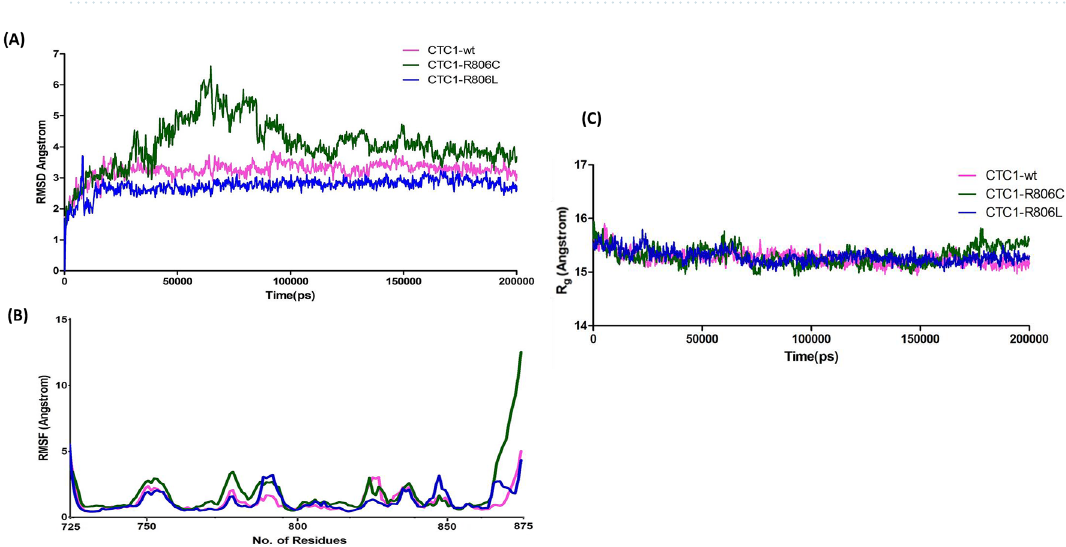
Figure 9. Conformational changes in CTC1 protein and its mutants. ( A ) Time evaluation of RMSD, ( B ) RMSF and ( C ) Radius of gyration of